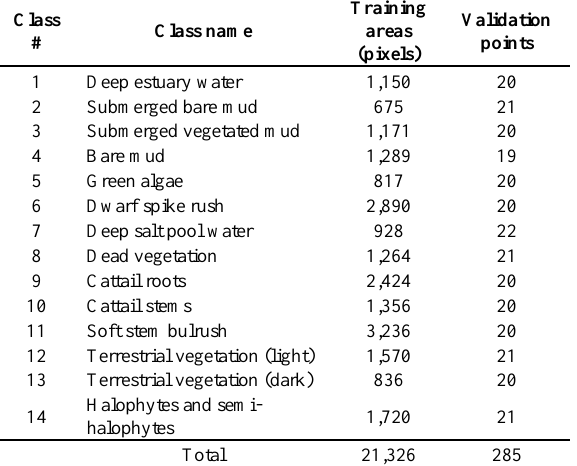
Table 3. Number of training areas and validation points per landcover class.